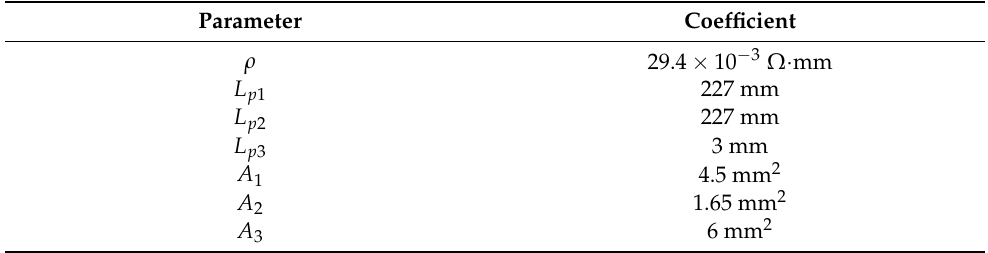
Table 4. Parameters for estimating the resistance of the different EGaIn soft sensors.